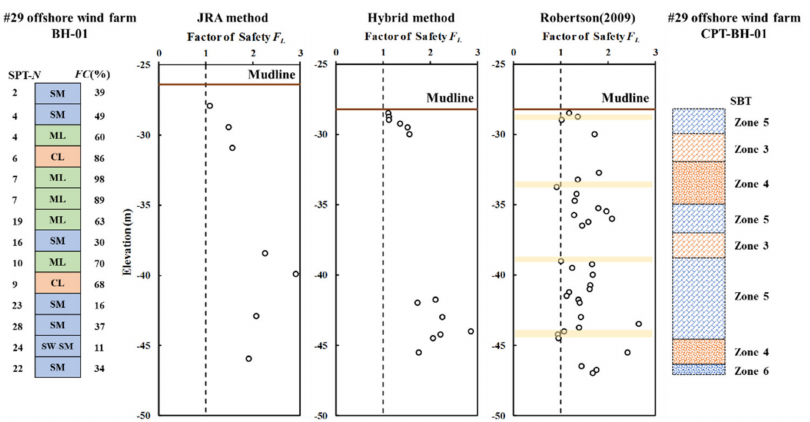
Figure 9. The soil liquefaction potential of boreholes CPT-BH-01 and SPT-BH-01 in #29 offshore wind